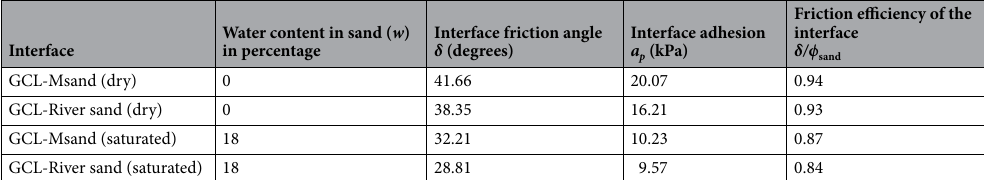
Table 2. Shear strength parameters from shear tests on GCL-sand interfaces.